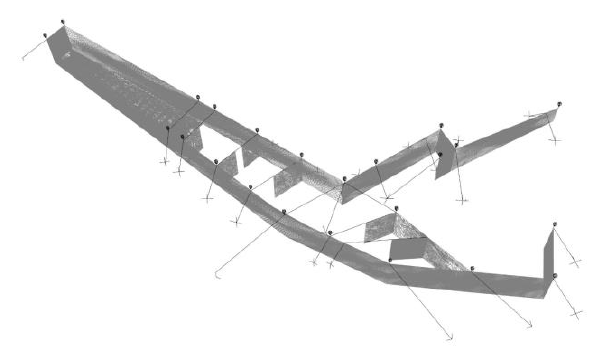
Figure 3. 3D model of a ‘madraga ’.